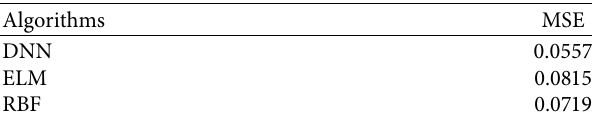
Table 4: MSE comparison for the three algorithms.